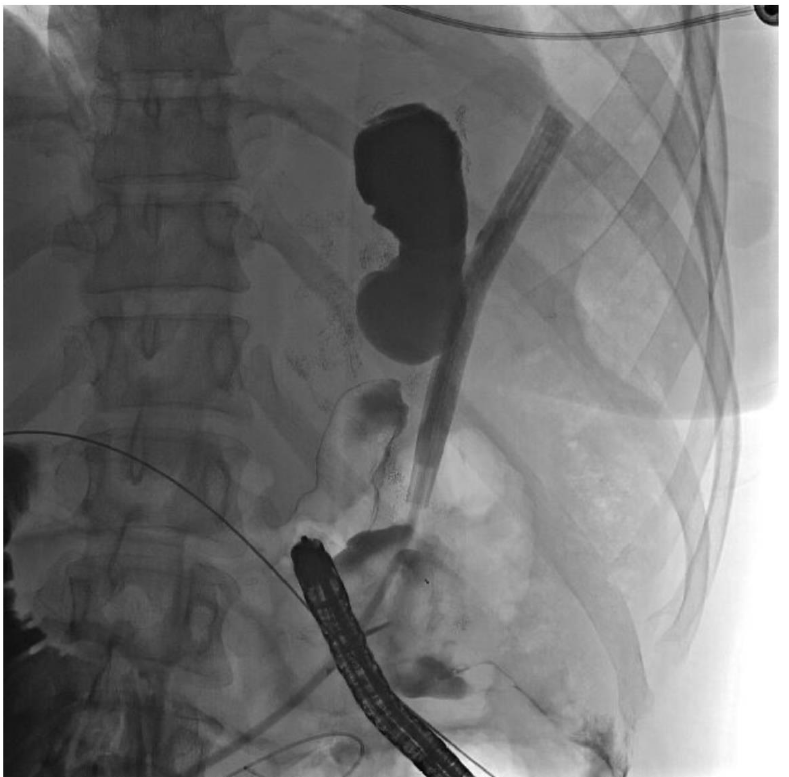
Figure 8. Sinogram during retrograde endoscopy to localize orphaned segment of stomach.